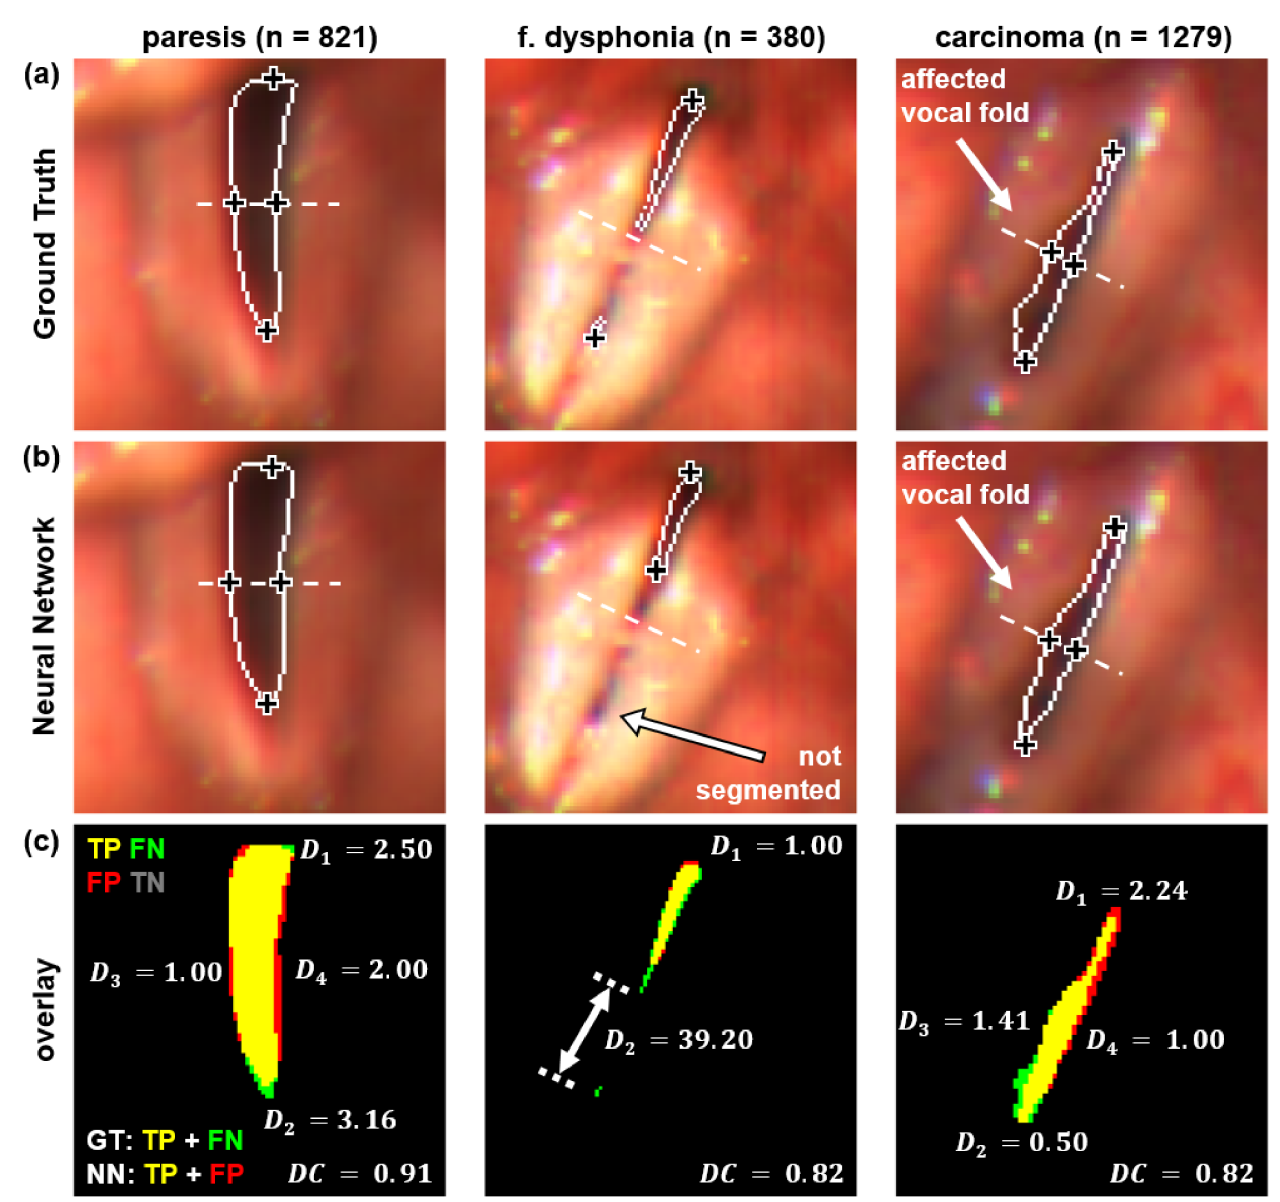
Fig 8. Comparison of landmark positions in three subjects (paresis, dysphonia, carcinoma). The landmarks P 1 - P 4 are marked with ‘+’. (a) Ground Truth (GT) segmentation. (b) Best performing Neural Network (NN) segmentation. Within the functional dysphonia case the landmarks P 3 and P 4 could not be identified due to an insufficient segmentation. (c) Color-coded segmentation overlay. Yellow: True Positive (TP), green: False Negative (FN), red: False Positive (FP), black: True Negative (TN). Measured deviations D 1 - D 4 are given in pixels. The high deviation for P 2 = 39.2 px results from the not properly segmented ventral part of the